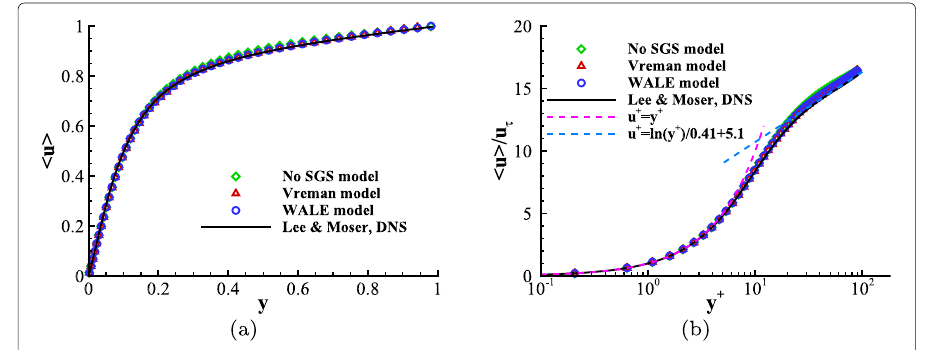
Fig. 10 The mean velocity profiles for the turbulent plane Couette flow at Re τ = 93. a outer scales, b inner scales